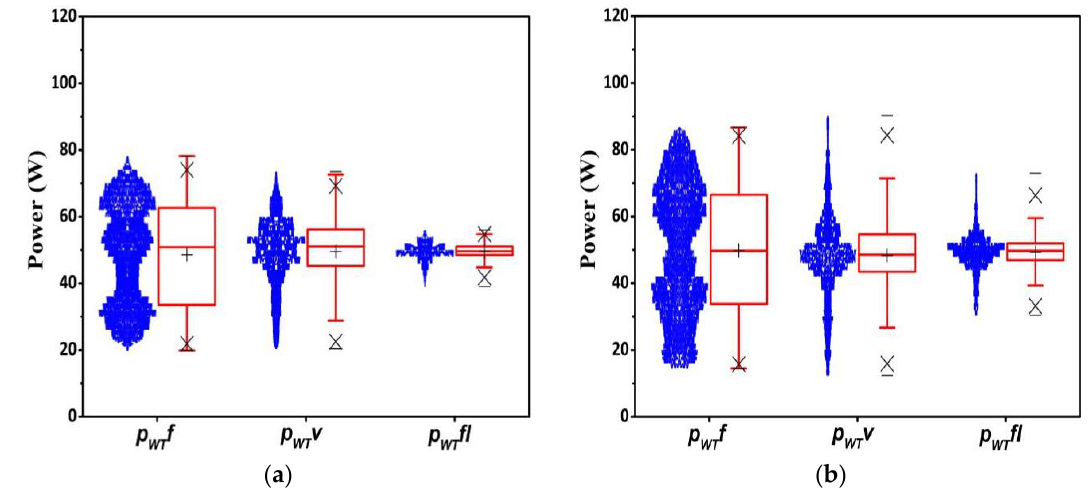
p at LPP1; ( b ) evolution of W T p W T